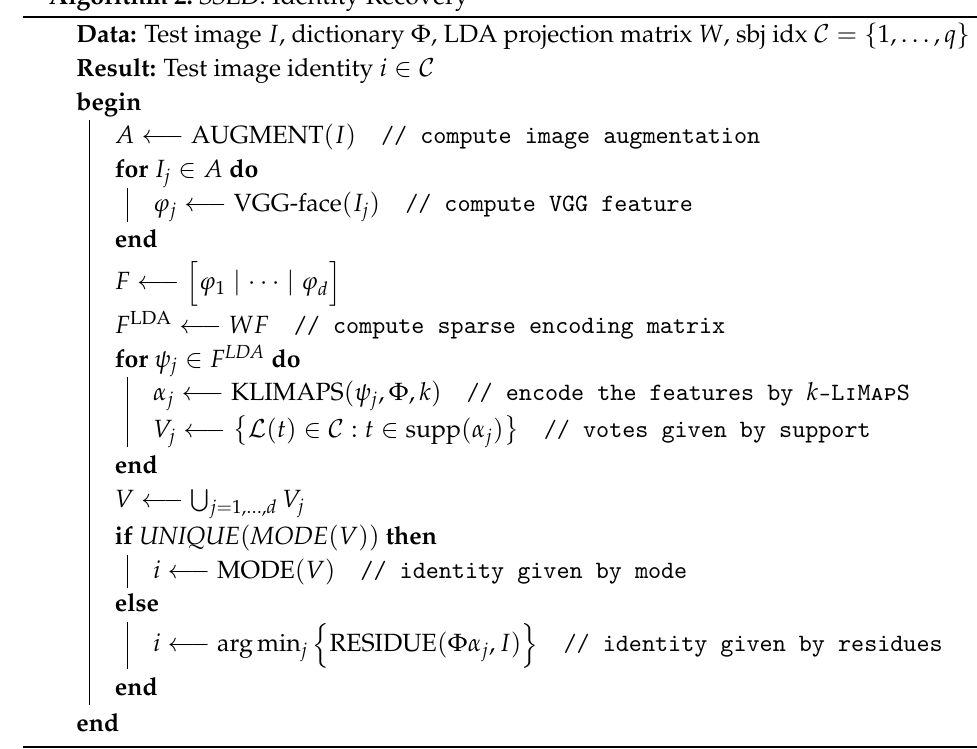
Algorithm 2: SSLD: Identity